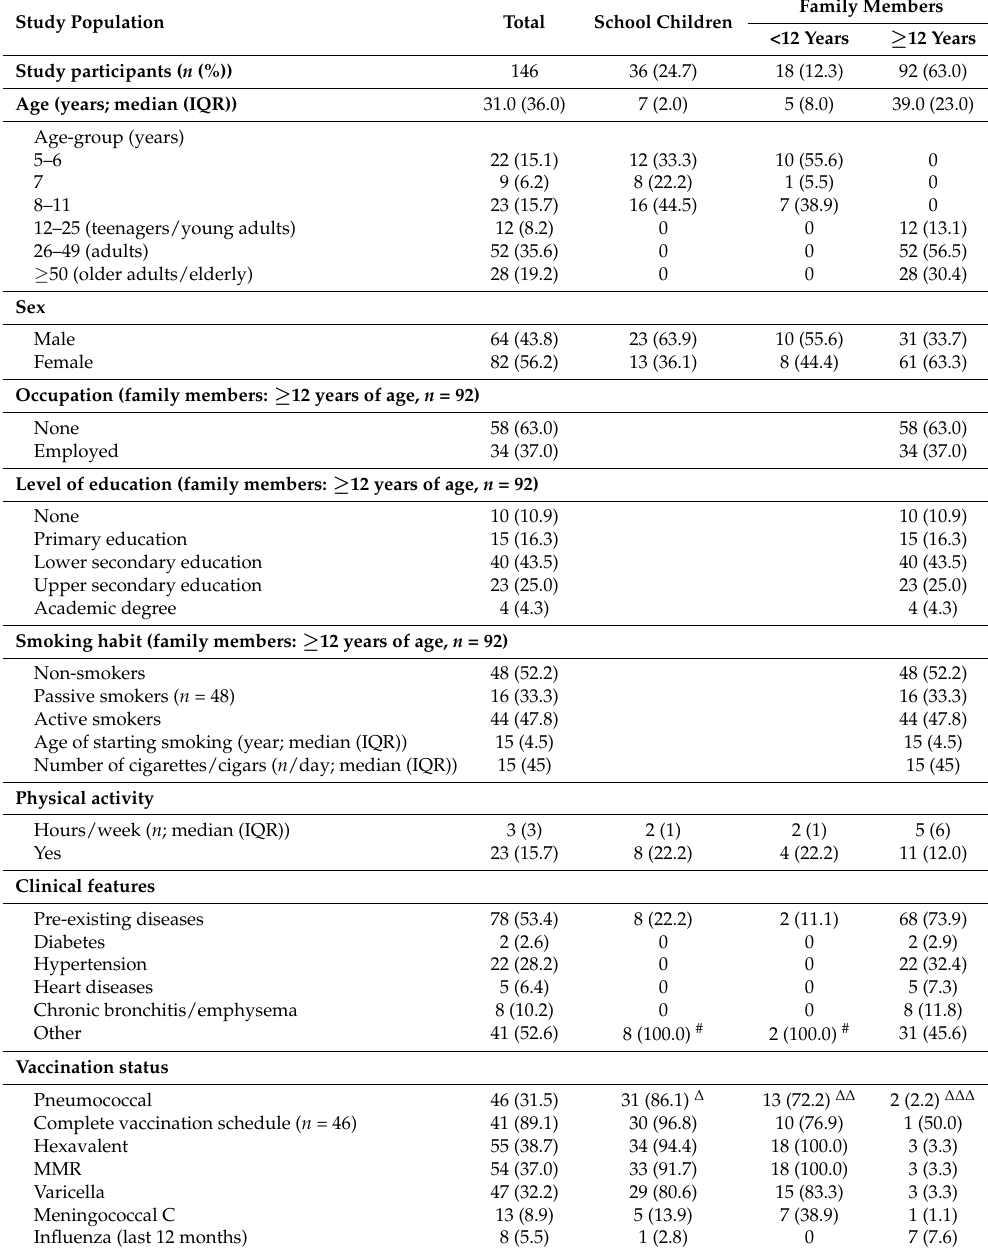
Table 1. Demographics, clinical characteristics and vaccination status of study